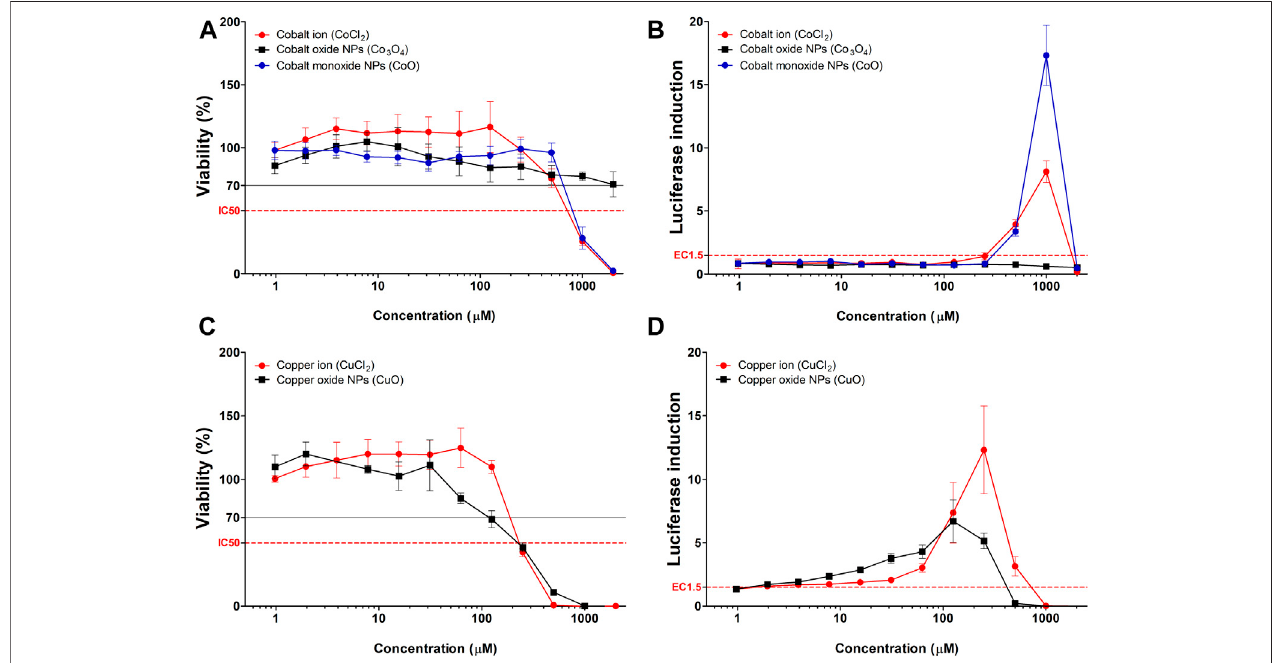
FIGURE 4 | Comparison of luciferase induction and cytotoxicity results between the chelated and non-chelated metal chlorides. (A) Viability and (B) luciferase induction of cobalt chloride (CoCl 2 ). (C) Viability and (D) luciferase induction of copper chloride (CuCl 2 ). Data are expressed as mean ± standard deviation values (n (cid:2) 6).